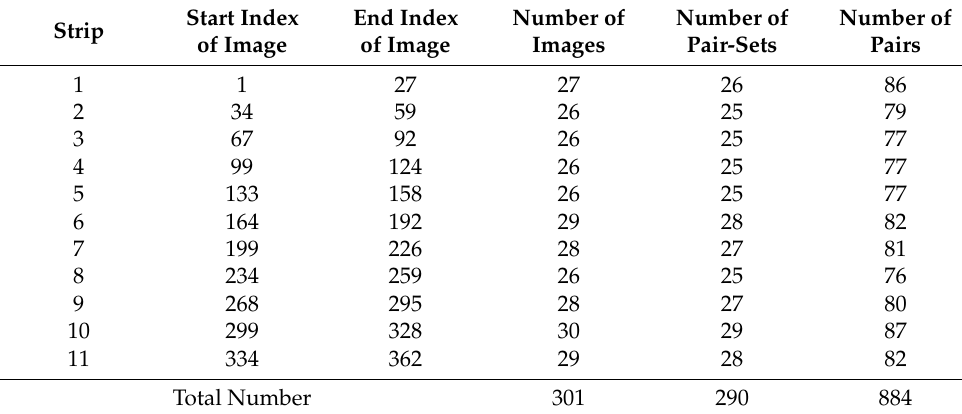
Table 1. The results of image grouping into strips.